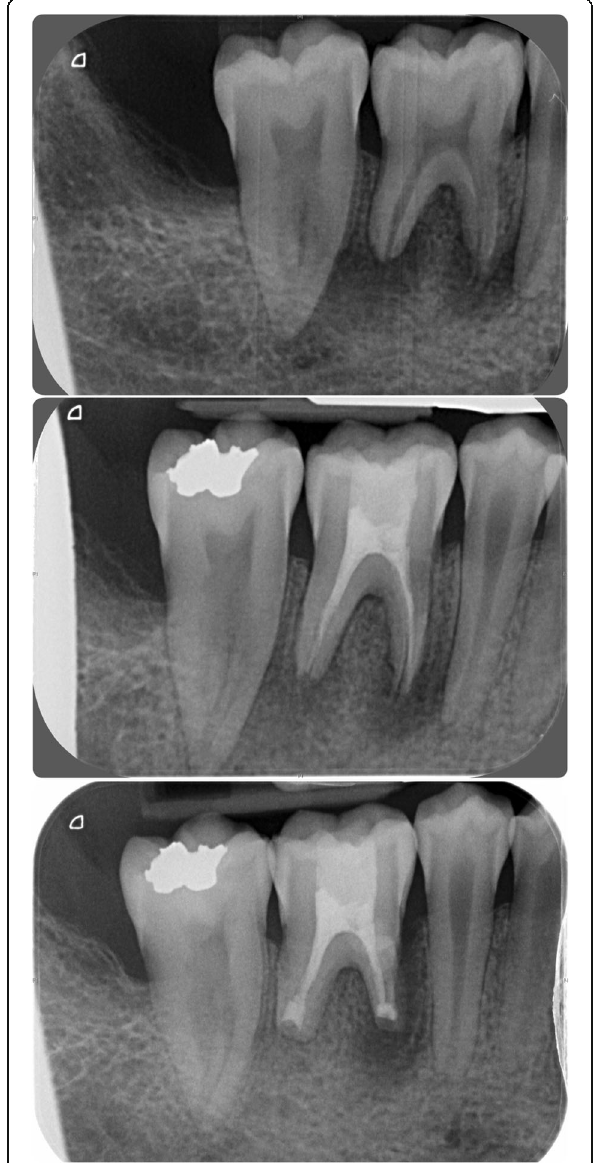
Fig. 9 Failed endodontic treatments. Above, resorption associated with 46 and 47 and a periapical radiolucency associated with 46; middle, attempted root canal therapy of tooth 46; below, attempted intentional reimplantation with extra-oral root end surgery and retrograde root filling of tooth